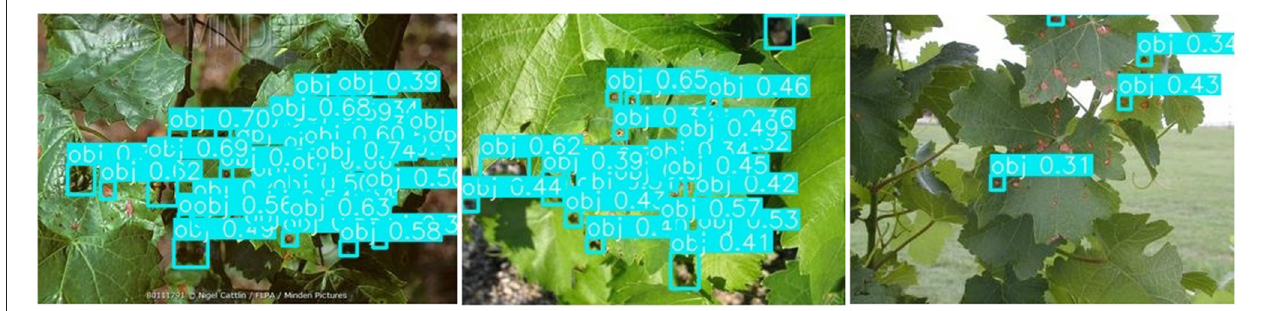
FIGURE 13 | Detection results of multi-leaf images.